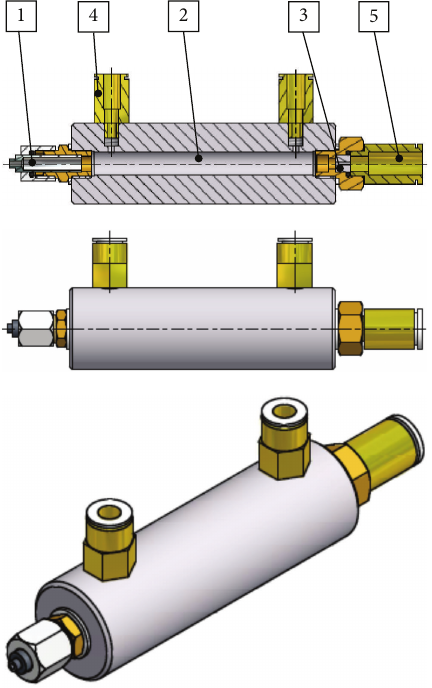
Figure 1: Investigation model of the air gauge: 1, replaceable mea- suring nozzle; 2, measuring chamber; 3, replaceable inlet nozzle; 4, joint for back-pressure sensor; 5, feeding joint.